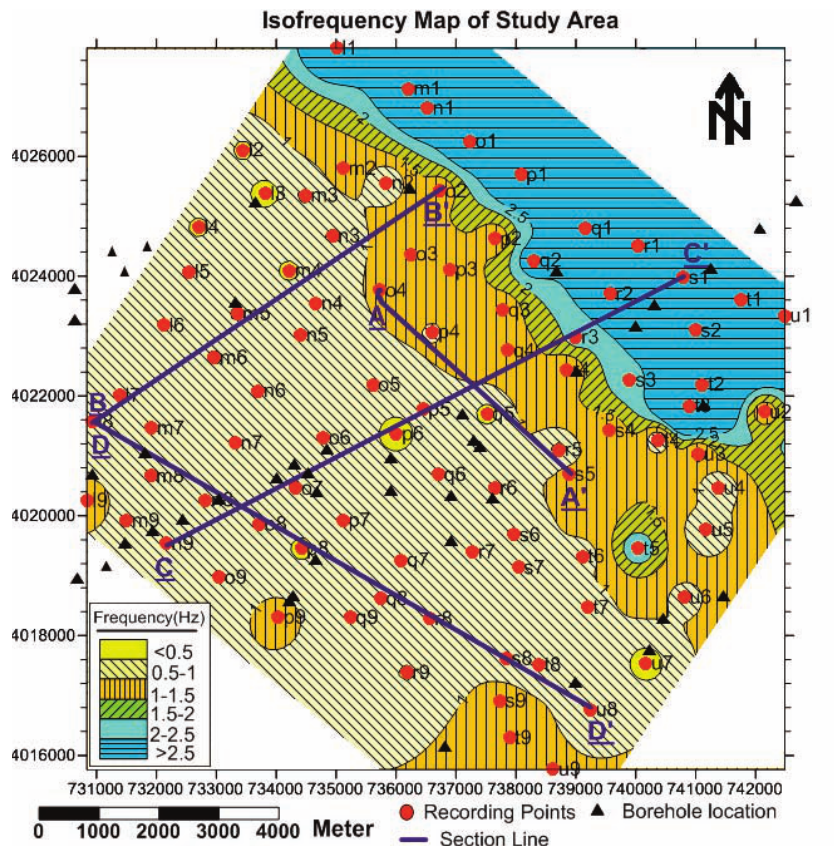
Figure 5. Iso-frequency map and locations of the boreholes (black triangles) and microtremor recording points (red circles) and the cross-sections discussed (thick black lines) for the study